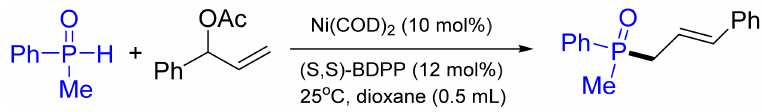
Figure 23. Ni-catalyzed asymmetric allylation of secondary phosphane